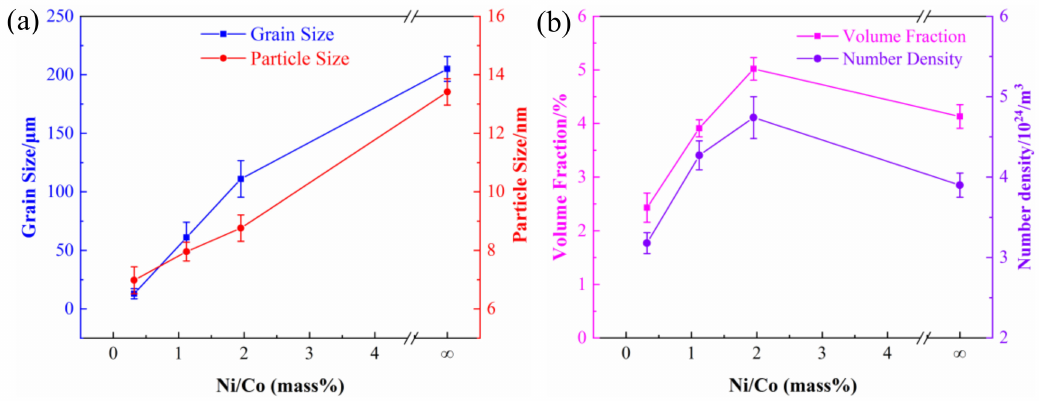
Figure 11. Variation curves of ( a ) the average grain and particle size and ( b ) the volume fraction and number density of alloys with di ff erent Ni / Co mass